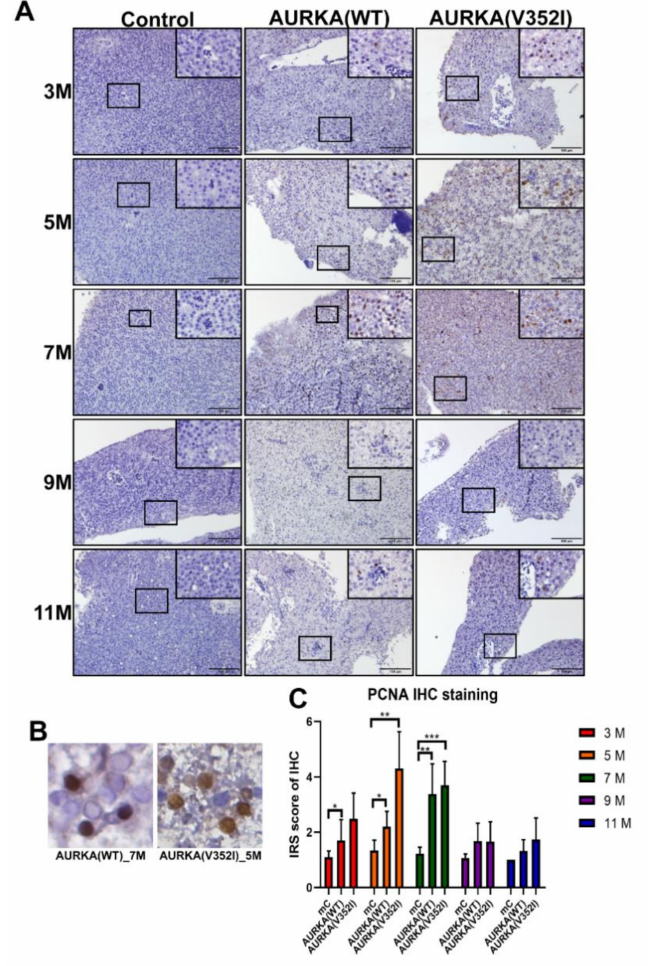
Figure 7. The immunoreactive score (IRS) of immunohistochemistry for the proliferating cell nuclear antigen (PCNA) was greater in AURKA(V352I) and AURKA(WT) than in control fish at 5 and 7 months. ( A ) Representative images of immunohistochemistry (IHC) staining for PCNA in control, AURKA(WT), and AURKA(V352I) at 3, 5, 7, 9, and 11 months; ( B ) Selected enlarged images show the nuclear signals of PCNA from AURKA(WT)—7 M and AURKA(V352I)—5 M; ( C ) Statistical analysis of PCNA immunostaining IRS score at 3, 5, 7, 9, and 11 months. IRS score of control fish (Tg(fabp10a:EGFP-mCherry) abbreviated as mC, AURKA(WT) and AURKA(V352I) is shown in red (3 M), orange (5 M), green (7 M), purple (9 M), and blue (11 M). Statistical analysis of results was performed using a two-tailed Student’s t -test. The error bar means standard deviation. Asterisks (*) represent the level of significance. * p -value ≤ 0.05; ** p -value ≤ 0.01; *** p -value ≤